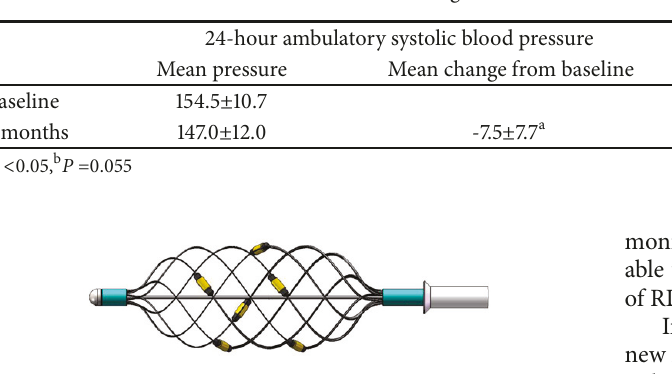
Table 2: Changes in Mean 24-hour ambulatory blood pressure.